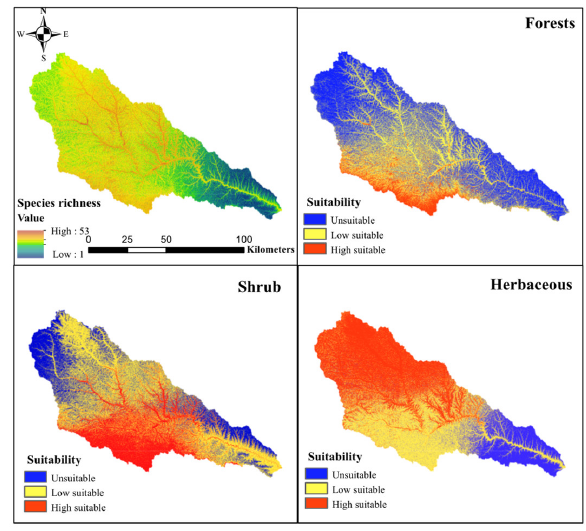
Figure 4. Vegetation distribution hotspots in the Yanhe River catchment. Table 4. The distribution area of species richness hot spots in the Yanhe River catchment (the first column represents various levels of species richness, the second column shows the corresponding area occupied, and the third column is the percentage of the distribution area in terms of the study area). Species